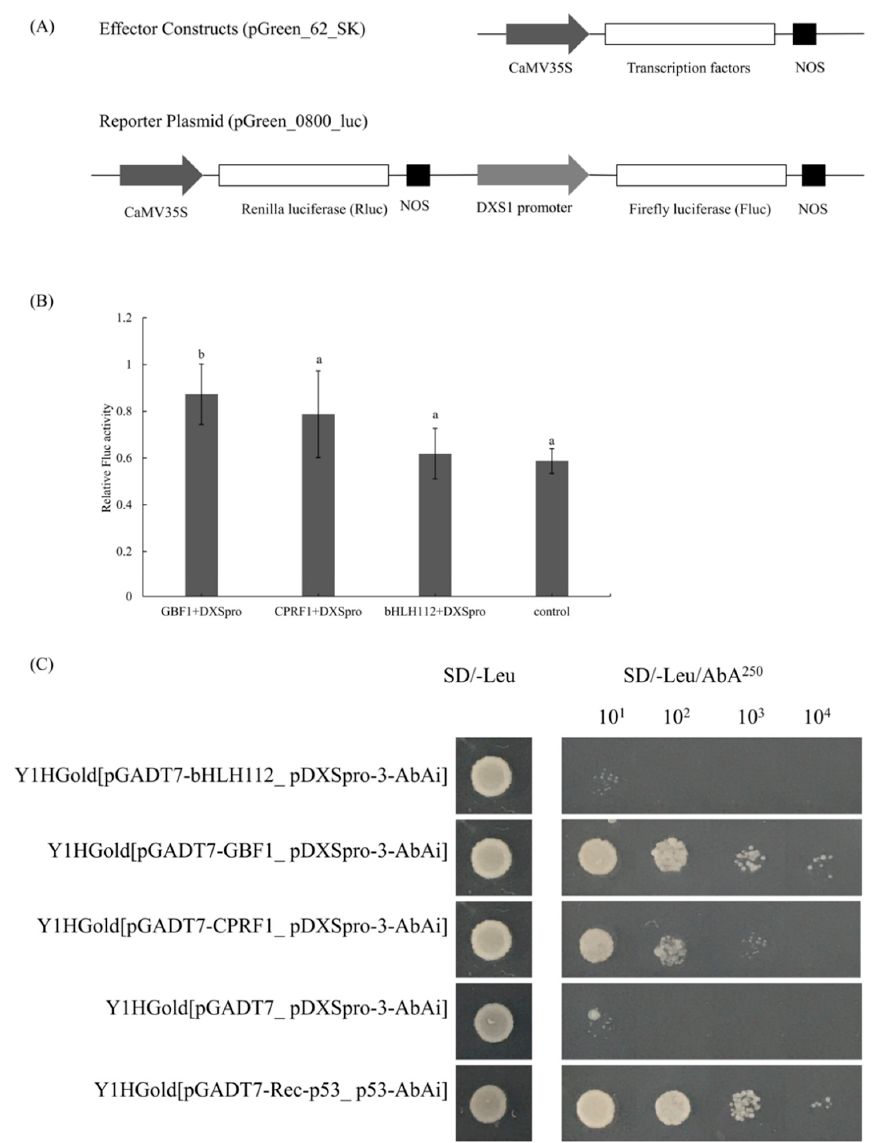
Figure 4. PpGBF1 transcription factor interacts with the deletion of PpDXS1 promoter region from A16. ( A ) Schematics of the normalization control, reporter, and effector construction. In the reporter